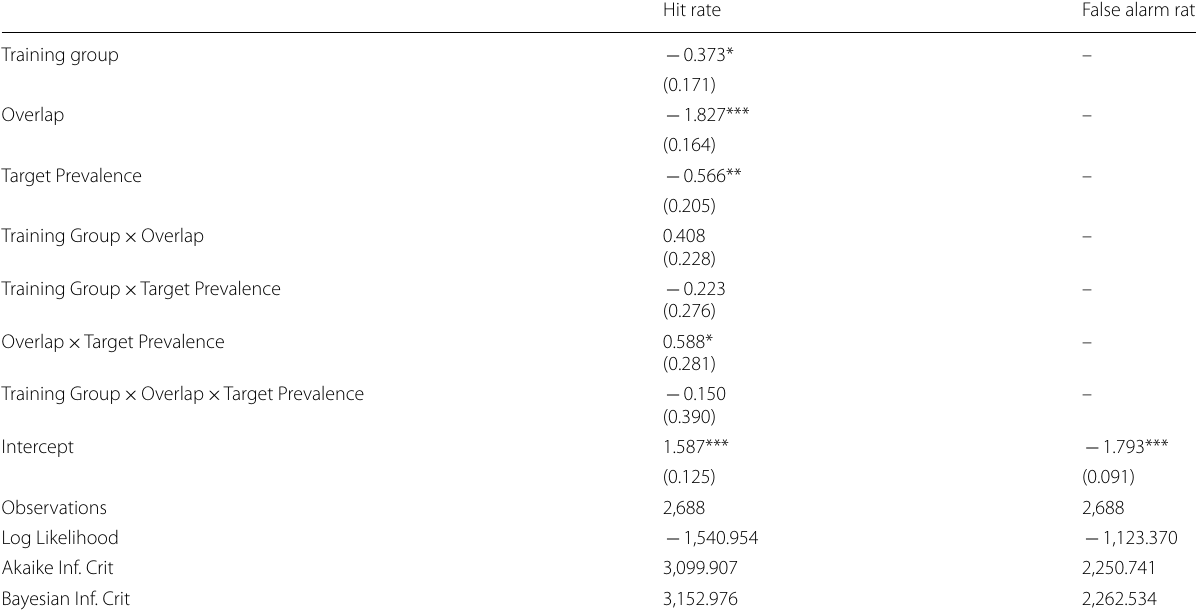
Table 5 Generalised linear mixed‑effects models comparing hit rate and false alarm rate including training group and overlap as factors in Experiment 4 (standard errors in brackets)